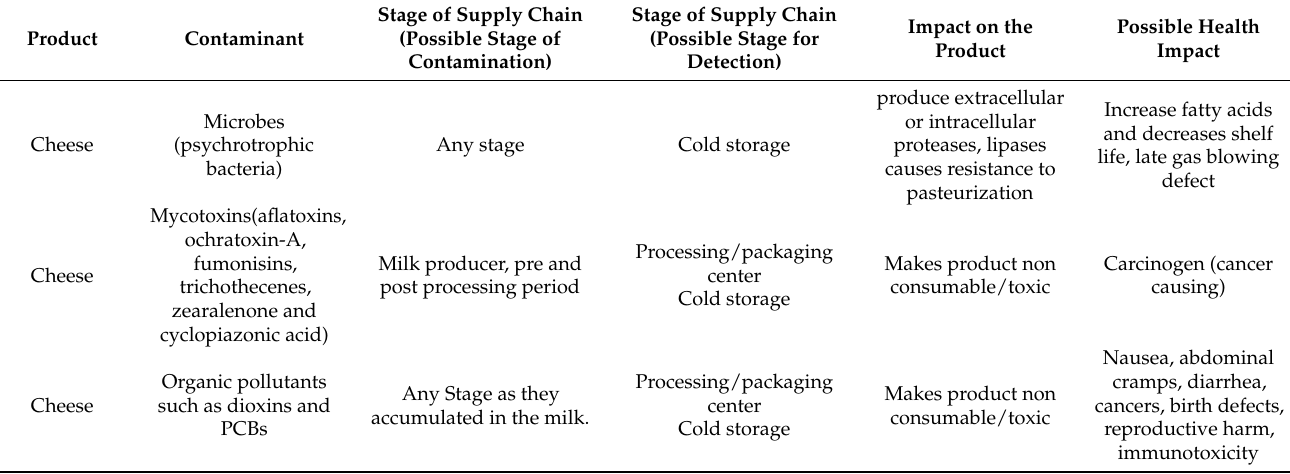
Table A6. Type of contaminants in cheese and their impacts on health and